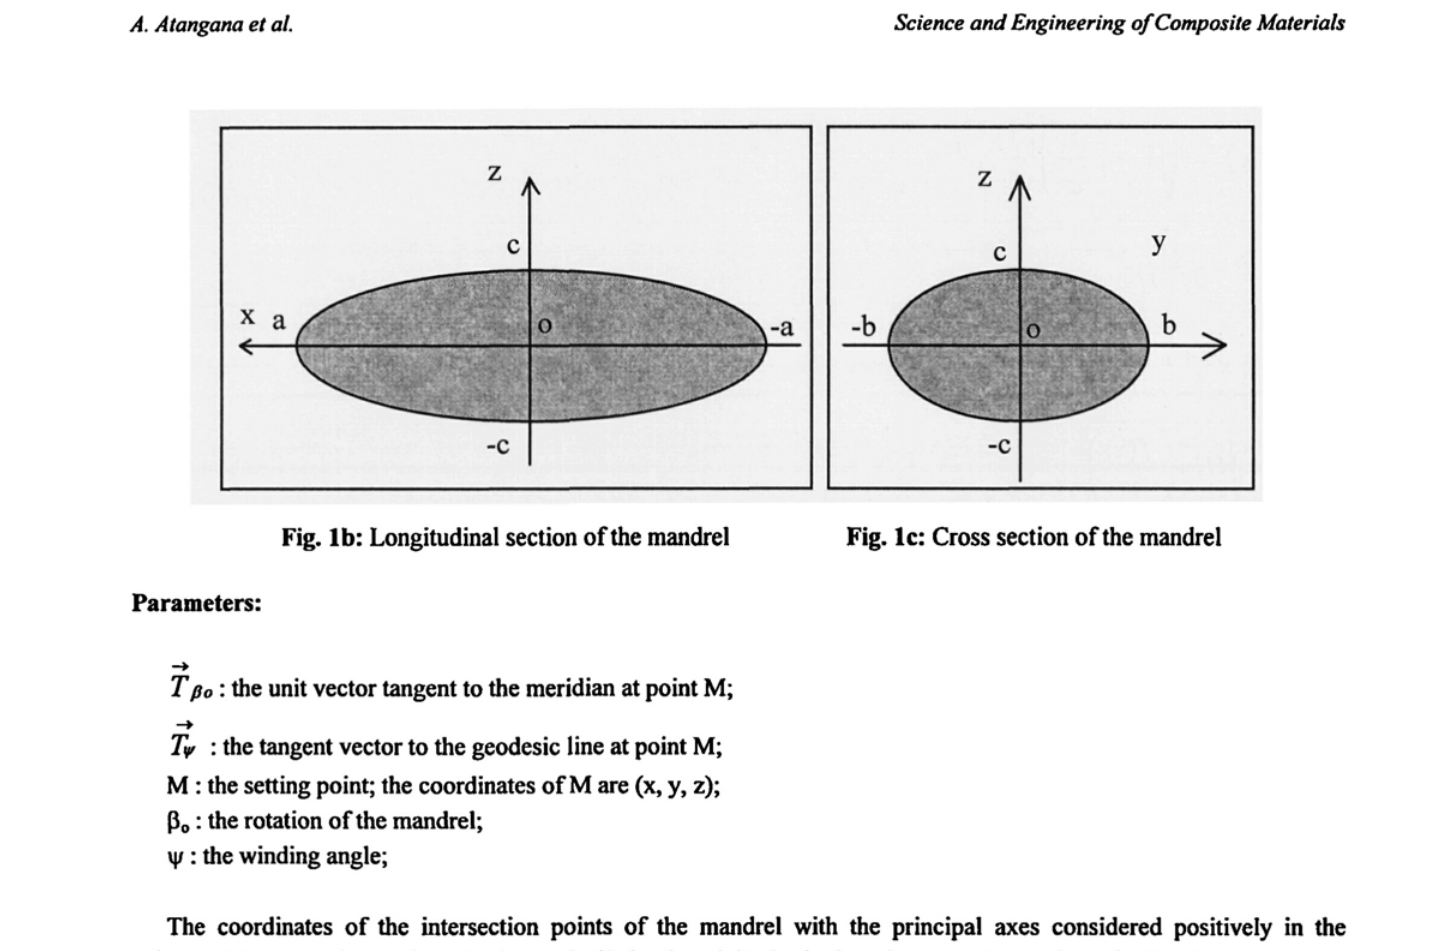
Fig. Ib: Longitudinal section of the mandrel Fig. Ic: Cross section of the